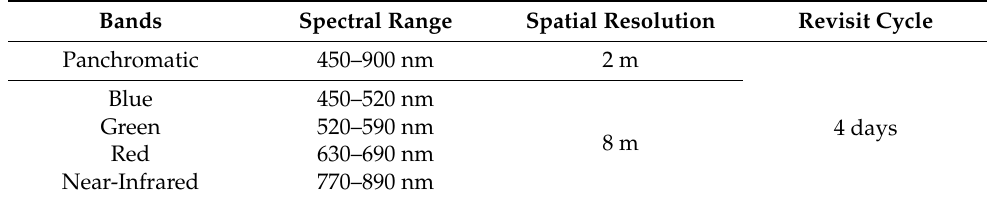
Figure 2. Different corn residue covered areas from GF-1 B/D image in Lishu County (R1 is corn high stubble residue covered area, R2 is short-stubble residue covered area, R3 is non-CRCA). Table 1. Band information of GF-1 B/D